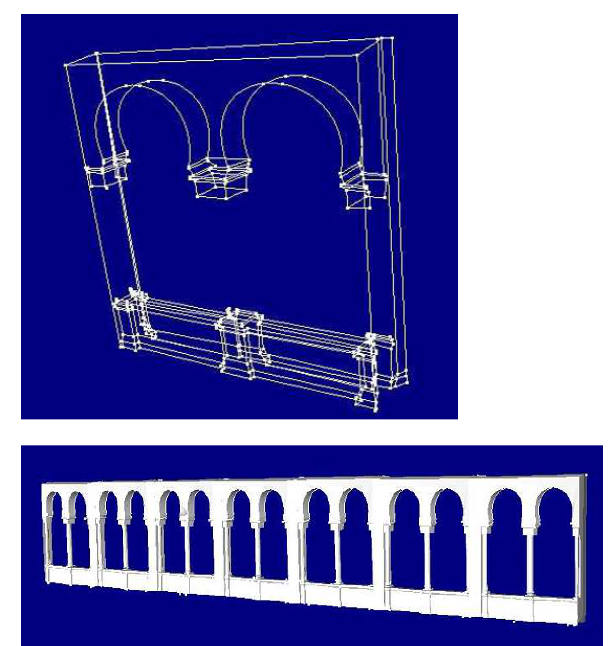
Figure 11. a. A model after line marking (up) b. a model after surfaces creation (bottom).